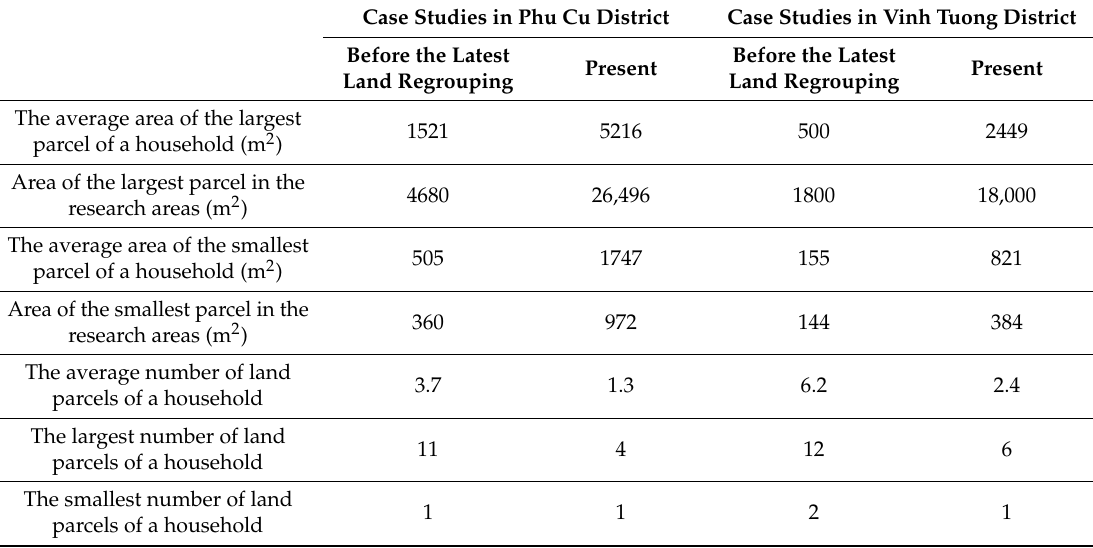
Table 5. Changes in area and number of agricultural land parcels. of interviewed households during land consolidation.